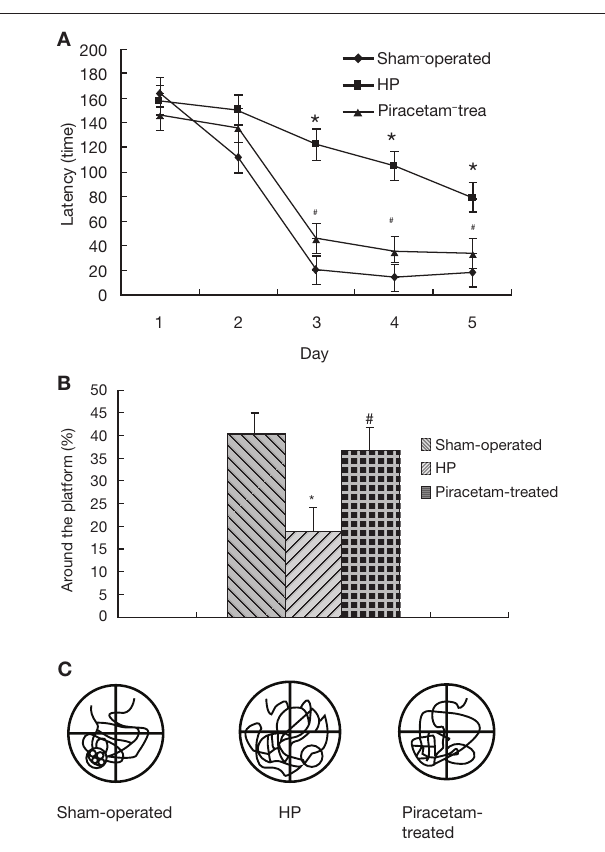
Figure 6 | Piracetam improves cerebral hypoperfusion-induced deficits in learning and memory. Rats were treated for 30 days with piracetam 600mg/kg per day after ligature of bilateral carotid arteries. The Sham-operated group was only treated with saline without induction of hypoperfusion. The Morris water maze was performed with four trials per day during 5 days for the acquisition test (A) , and performed with four trials on day 6 without the platform retention test ( n = 10 ± SEM) (B) . Representative examples of typical swim-tracking pathways in probe trial on training day 6 no platform (C). ( n = 10 ± SEM). Data are reproduced from He et al. (2008) with permission. * p < 0,01 vs. Sham-operated, and # p < 0.05 vs. control hypoperfusion. Tukey’s test following a repeated ANOVA.